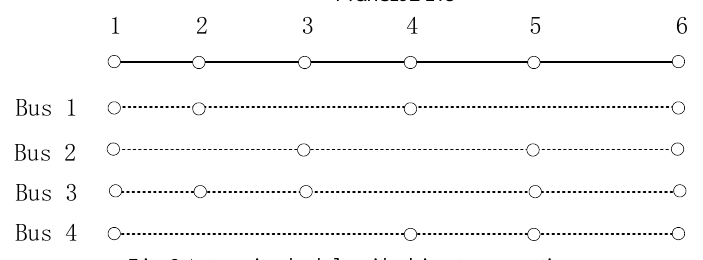
Fig. 2 A transit schedule with skip-stop